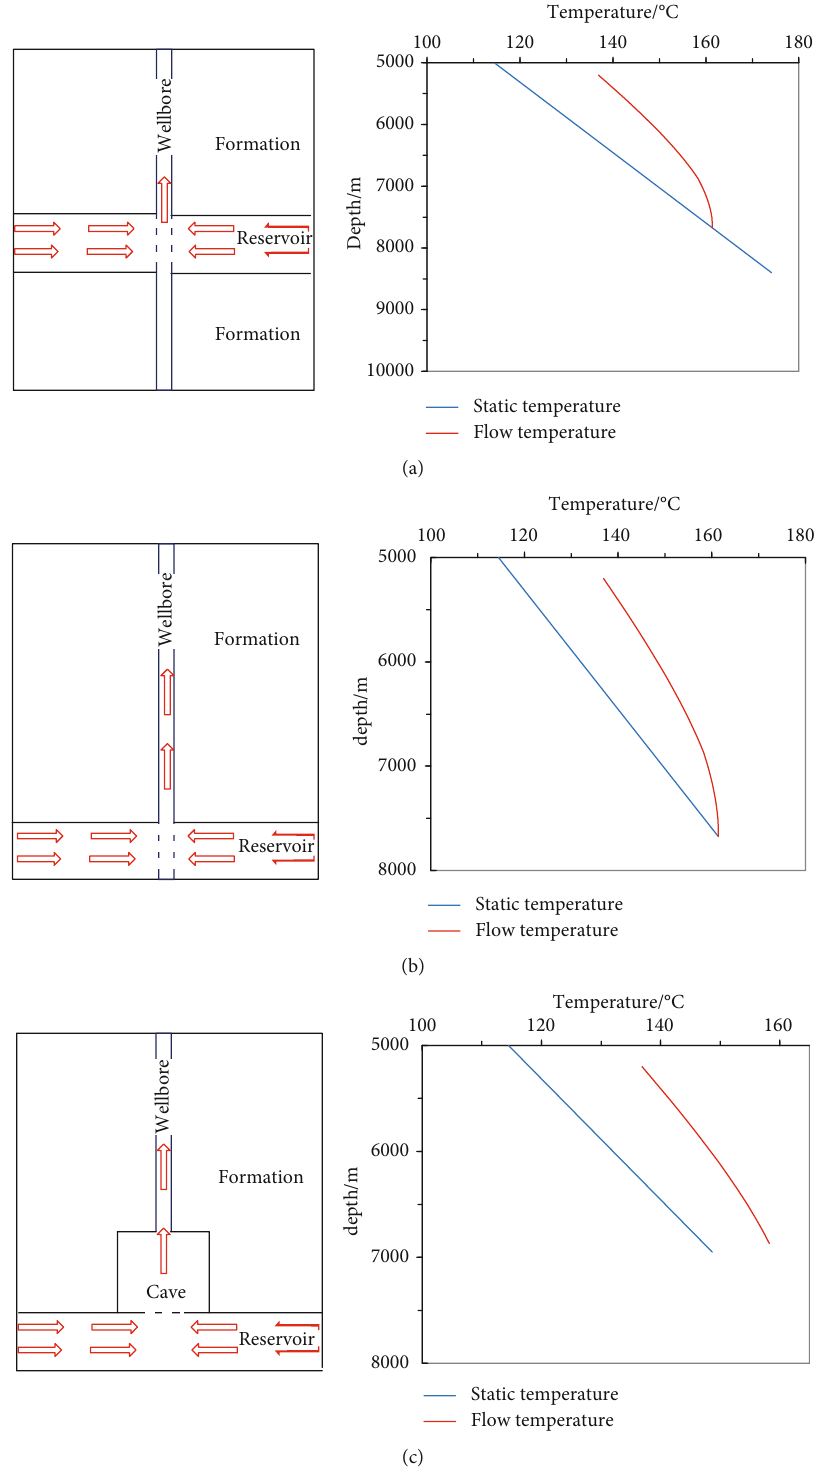
Figure 2: Illustration of temperature fi elds for production wells at di ff erent reservoir locations: (a) middle; (b) bottom; (c)